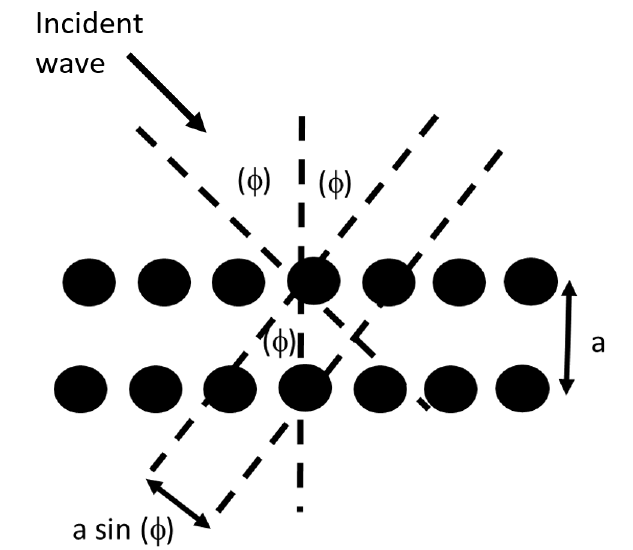
Figure 1. Scattering phenomenon of plane sound waves across a two-row array of cylindrical scat- terers.